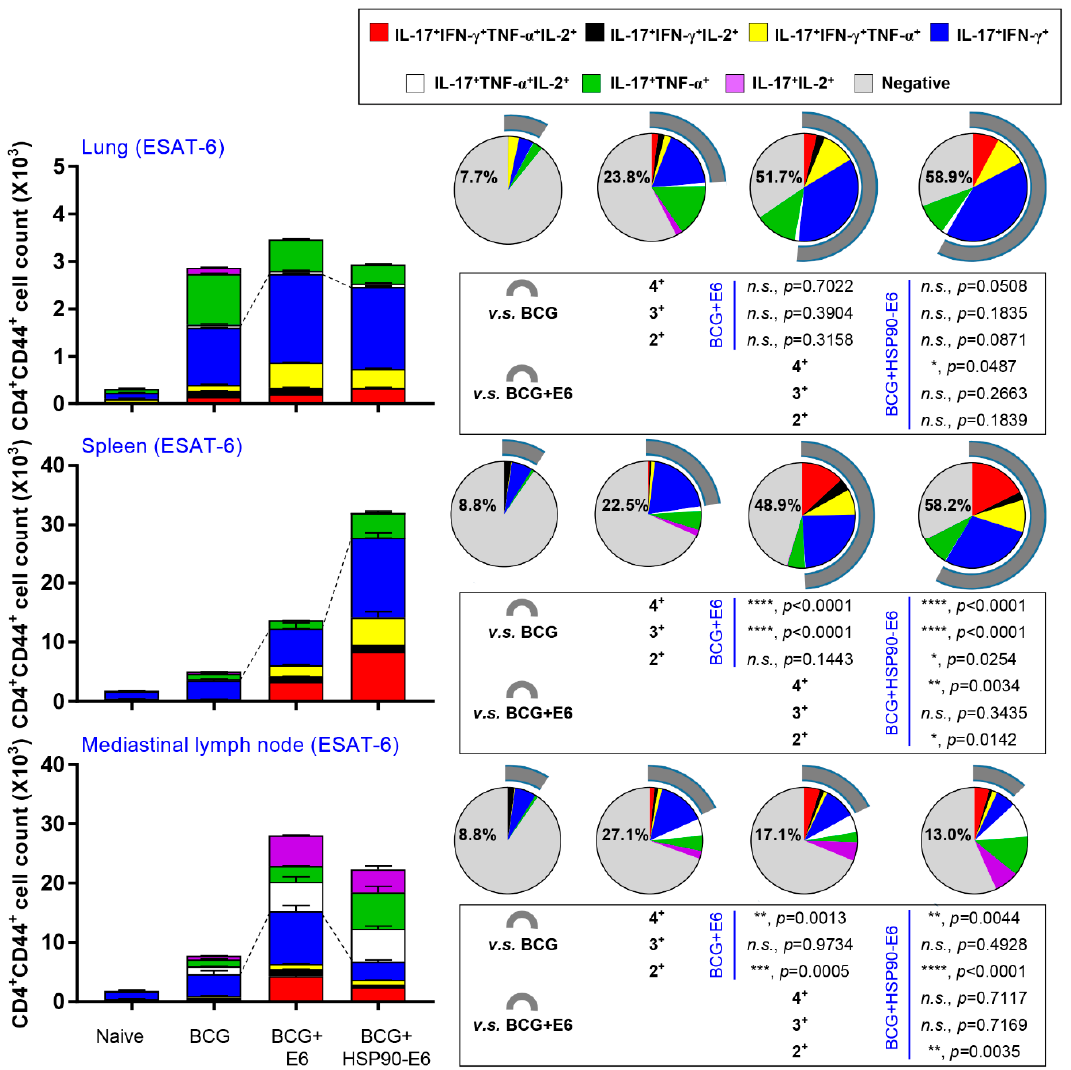
Figure 2. Induction of Ag-specific multifunctional T-cells in the lungs, spleen, and lymph nodes in BCG + HSP90-E6-immunised mice. Mice were immunised and euthanised, as described in the Methods section. Four weeks after the last immunisation, the mice were sacrificed, and their lung, spleen, and lymph-node cells collected from the mice were treated with ESAT-6 (2 μ g/mL) at 37 °C for 12 h in the presence of GolgiStop. Upon stimulation with ESAT-6, cell counts of Ag-specific, multifunctional CD4 + CD44 + T-cells producing IFN- γ , IL-17 and/or TNF- α and IL-2 in the lung, spleen, and lymph-